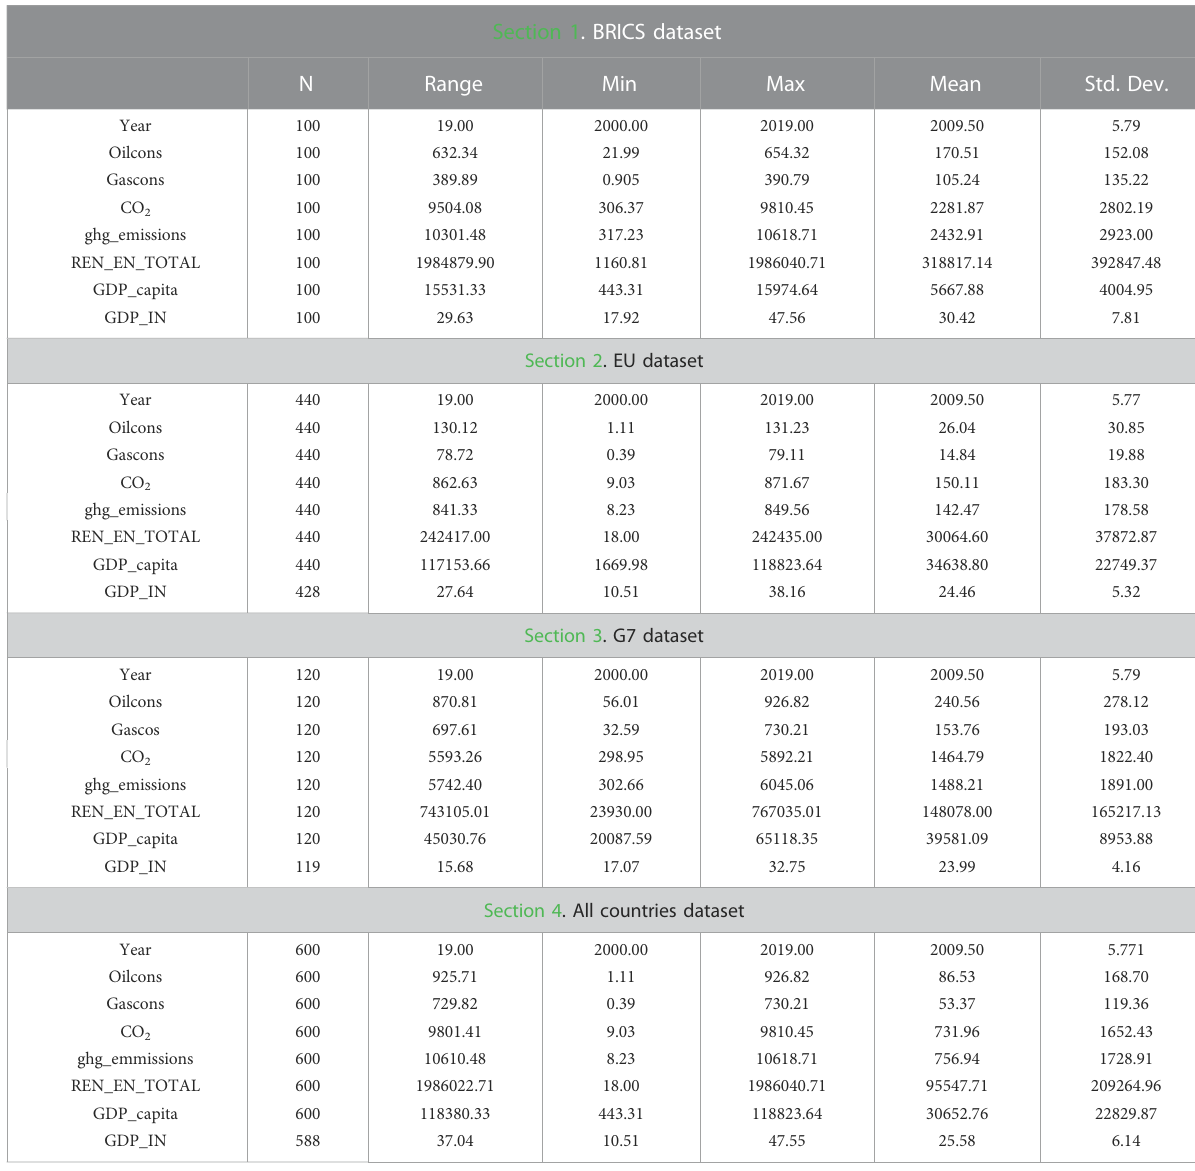
TABLE 2 Dataset descriptive statistics.